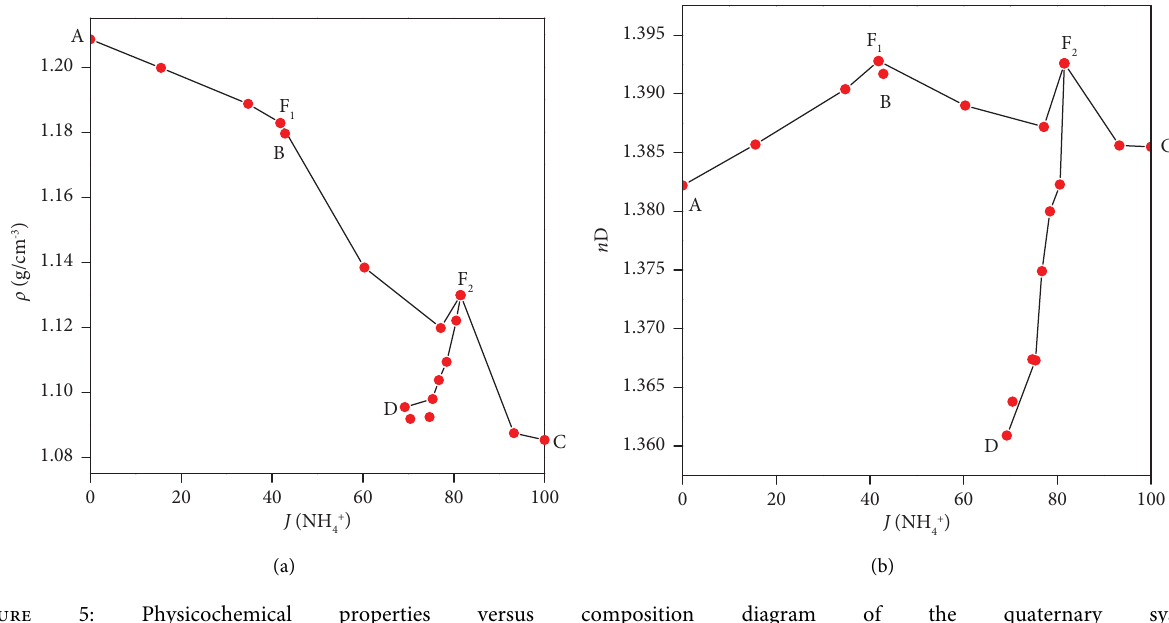
5: Physicochemical properties versus composition diagram of the quaternary system